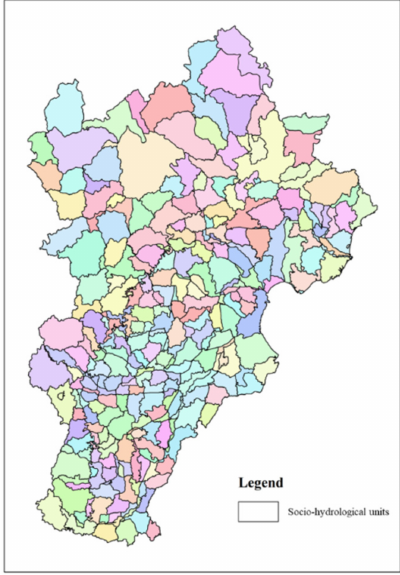
Figure 8. Socio-hydrological units of the study area.